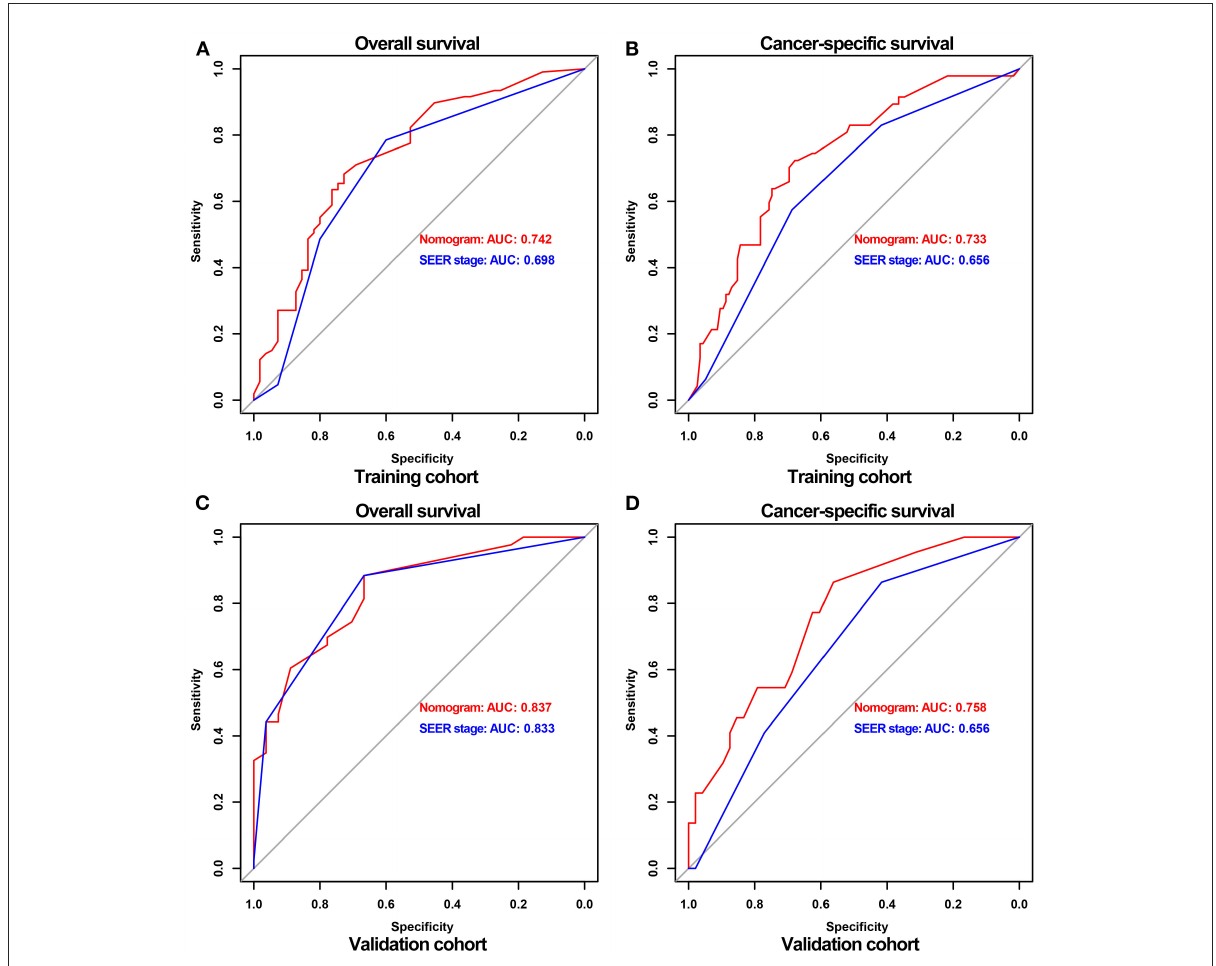
FIGURE3 ROC curves of nomograms and the SEER stage for predicting OS and CSS probabilities in the training and validation cohort. ROC for OS (A) and CSS (B) in the training cohort, respectively; ROC for OS (C) and CSS (D) in the validation cohort, respectively.